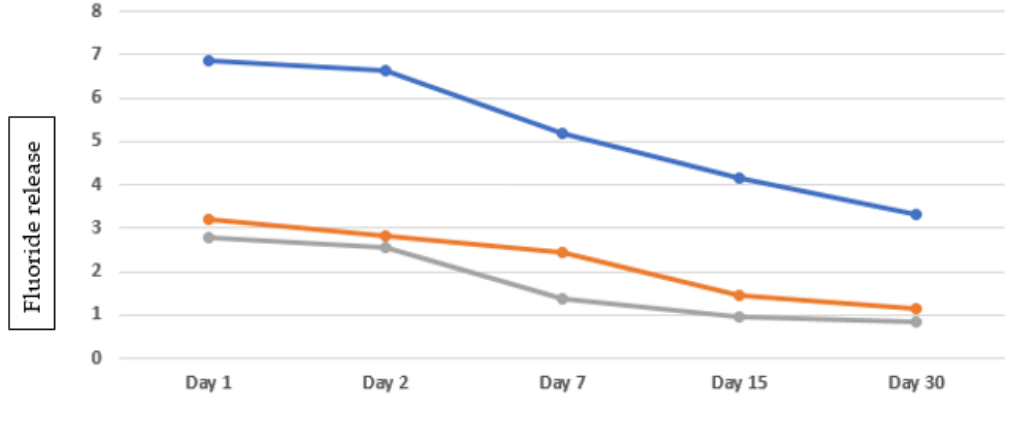
Figure 3. Pattern of fluoride release from the three groups at different time intervals with fluoride recharge.